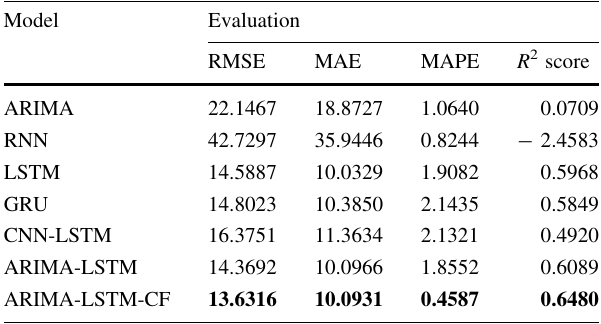
Table 6 Evaluation results of different prediction models on another dataset Model